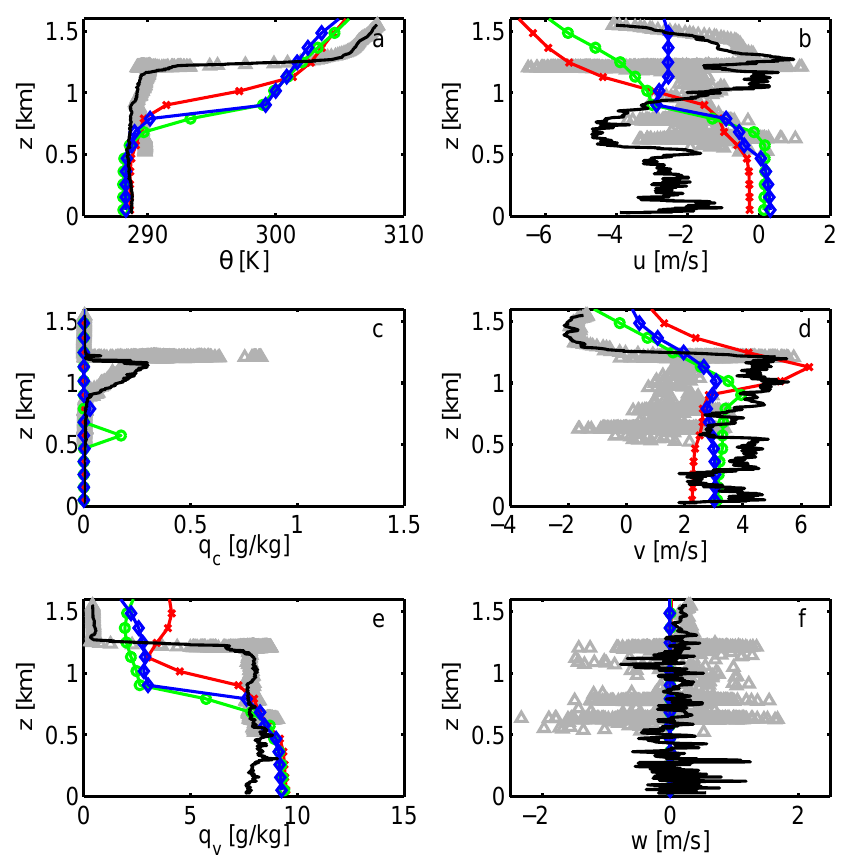
Fig. 5. Model sensitivity to the initialization time for the run with 81 vertical levels and for profile 4; black line – observations, blue – 00:00UTC on 12 November 2008, green – 00:00UTC on 10 November 2008, red – 00UTC on 5 November 2008; gray points – variability of measurements.